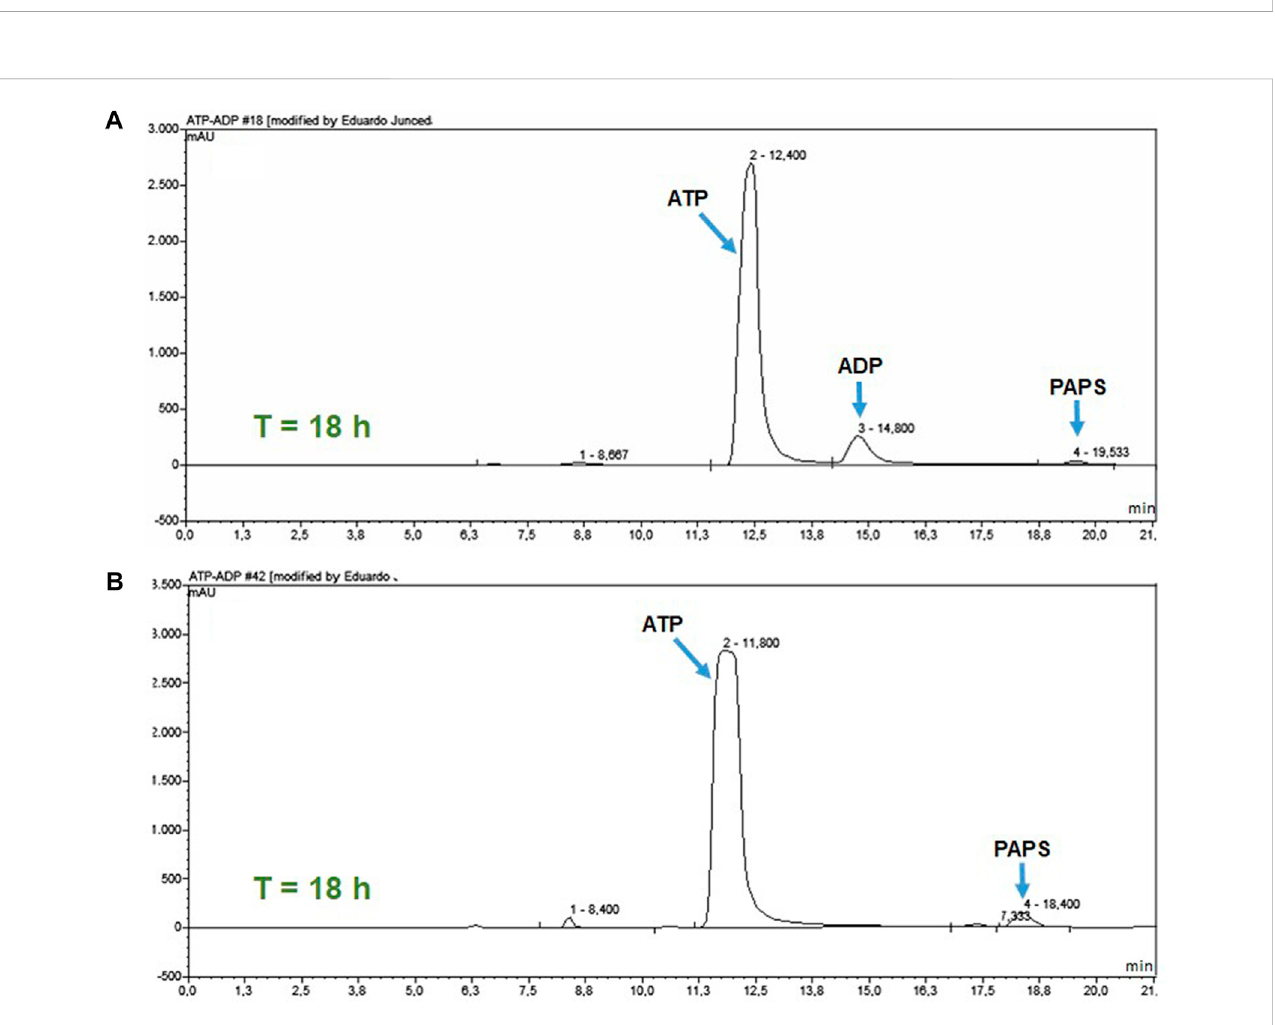
FIGURE 6 HPLC analysis of the ATP regeneration module at 18 h of reaction. (A) PAPS synthesis reaction without the coupled regeneration system. (B) Reaction with the coupled ATP regeneration module.